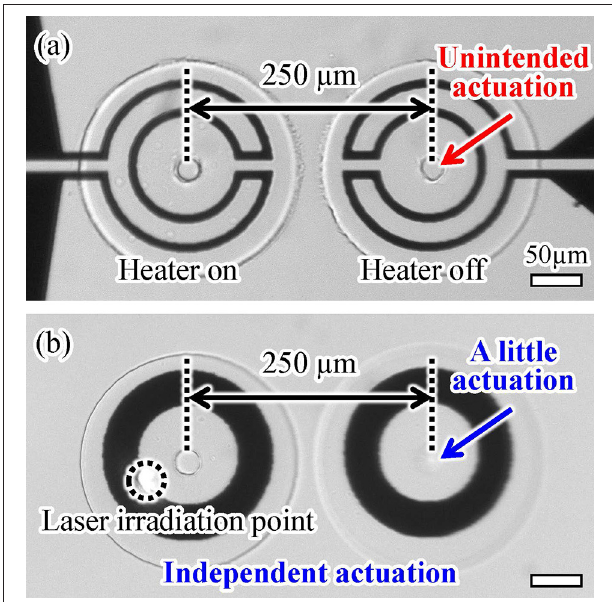
FIGURE 10 | Integrability of two (a) microheater-driven and (b) light-driven actuators with a short separation distance.